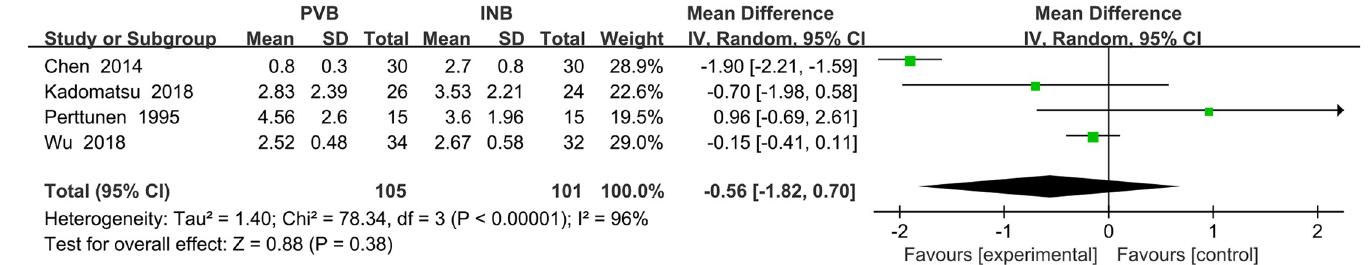
Fig 6. Forest plot of comparison: PVB VS INB. Outcome: VAS at rest at the first 2 h.